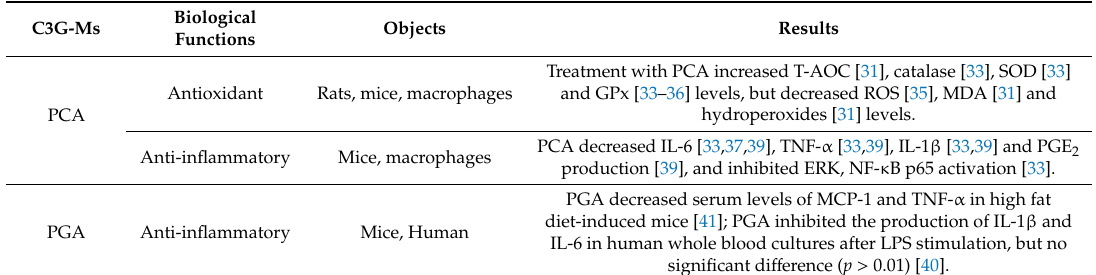
Table 1. Biological functions of